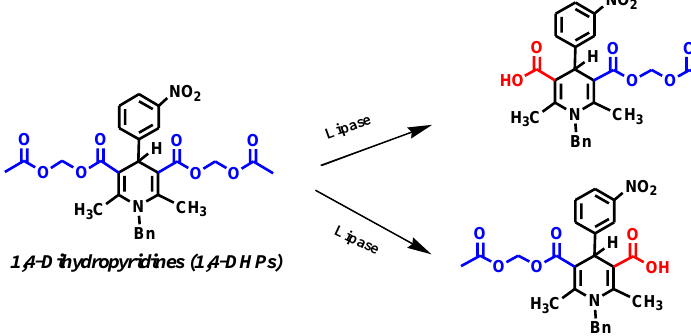
Using t-butyl methyl ether as the solvent in addition to methanol as the nucleophile for Pseudomonas lipase and water as the nucleophile for C. rugosa lipase (CRL), the transformations of 1,4-DHPs were investigated (Scheme 2)